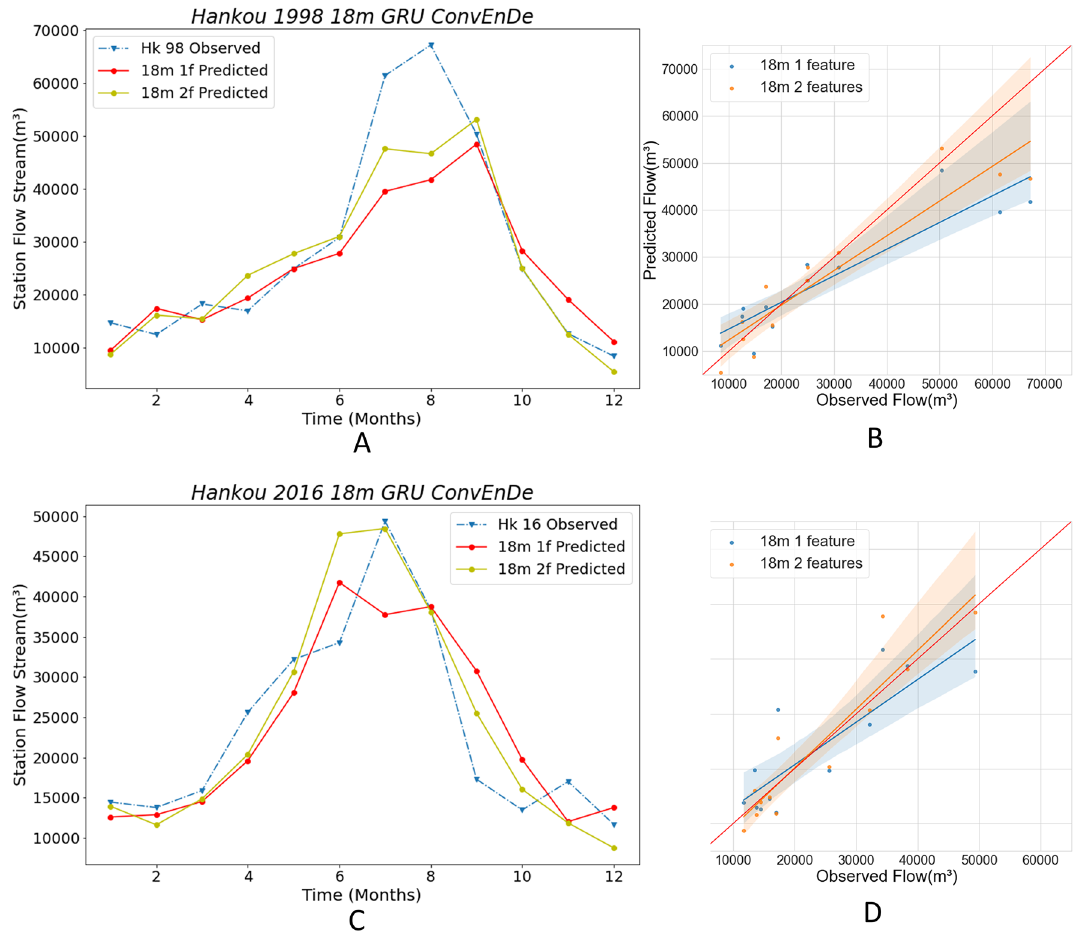
Figure 16. Comparison with different features in Hankou station.The solid lines in A, C plot the predicted values using different numbers of feature data, and the blue dashed lines are the observed values. ( B, D ) The scatter plots corresponding to A, C